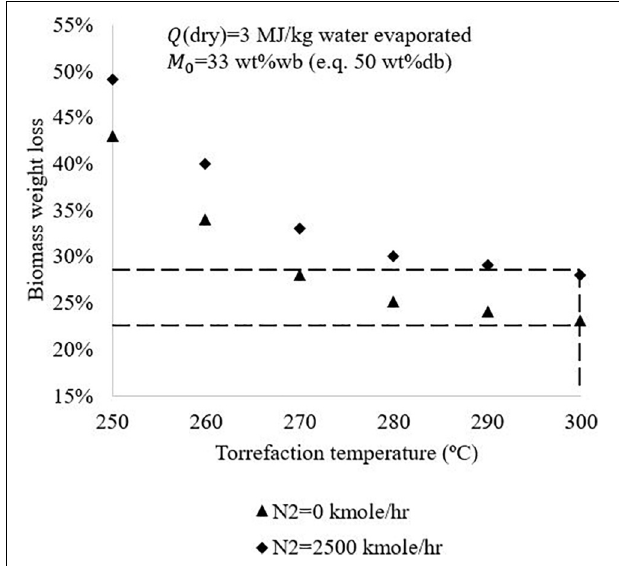
FIGURE 6 | Influence of N 2 flowrate used for torrefaction on the torrefaction process auto-thermal boundary.